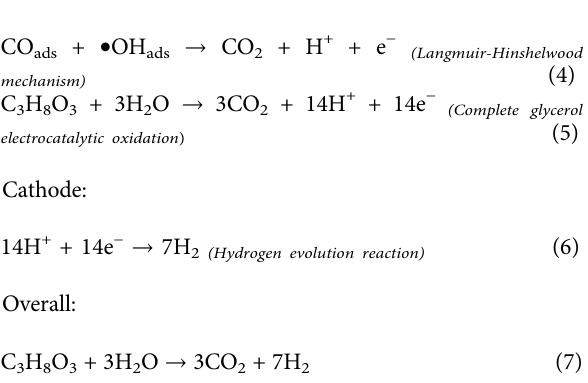
Frontiers in Chemistry |